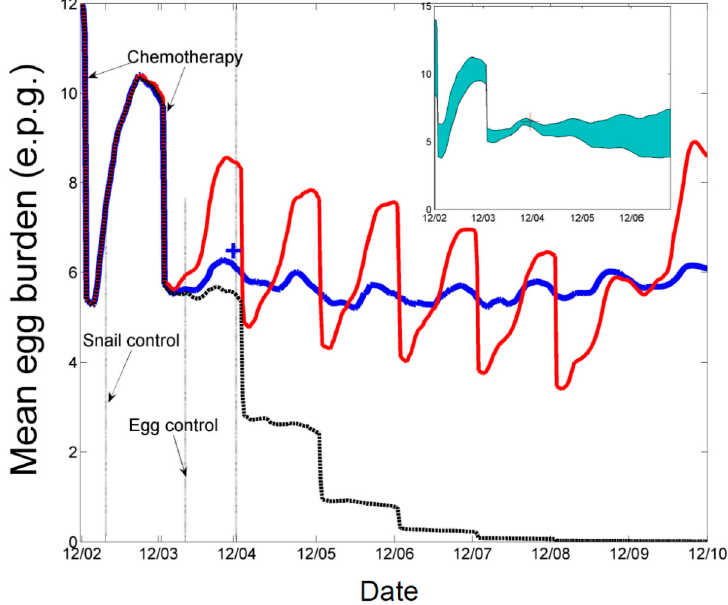
Figure 1. Time profiles of median infection intensity for farmers in Chuanxing Xinlong 7 under three hypothetical control scenarios. Scenario I, blue , two chemotherapies in 2002 and 2003, coupled with sustained environmental interventions to 2010; II, red , chemotherapies as in scenario I followed by annual chemotherapy at 50% coverage to 2008, no environmental interventions; III, black , a combination of both scenarios I and II. The inset in the upper right of the figure shows the variability model predicts around the blue line due to residual uncertainty in parametric values.